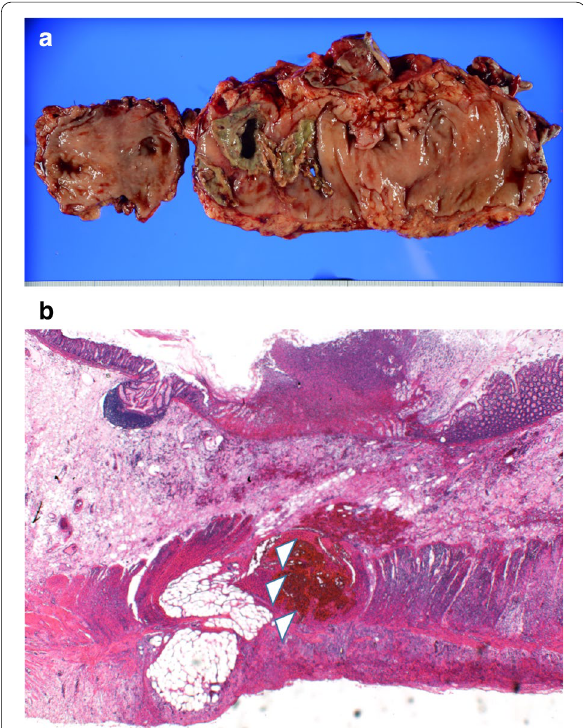
Fig. 3 a Perforated sigmoid colon. b Infiltration of inflammatory cells and rupture of the muscular layer (white triangles) are observed, and collagen fibers in the submucosal layer tend to be slightly thin